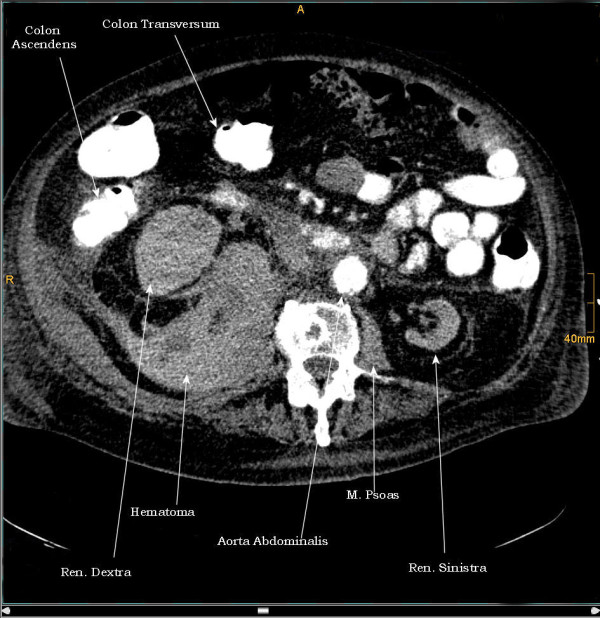
4th case. CT - axial plan of the hematoma.